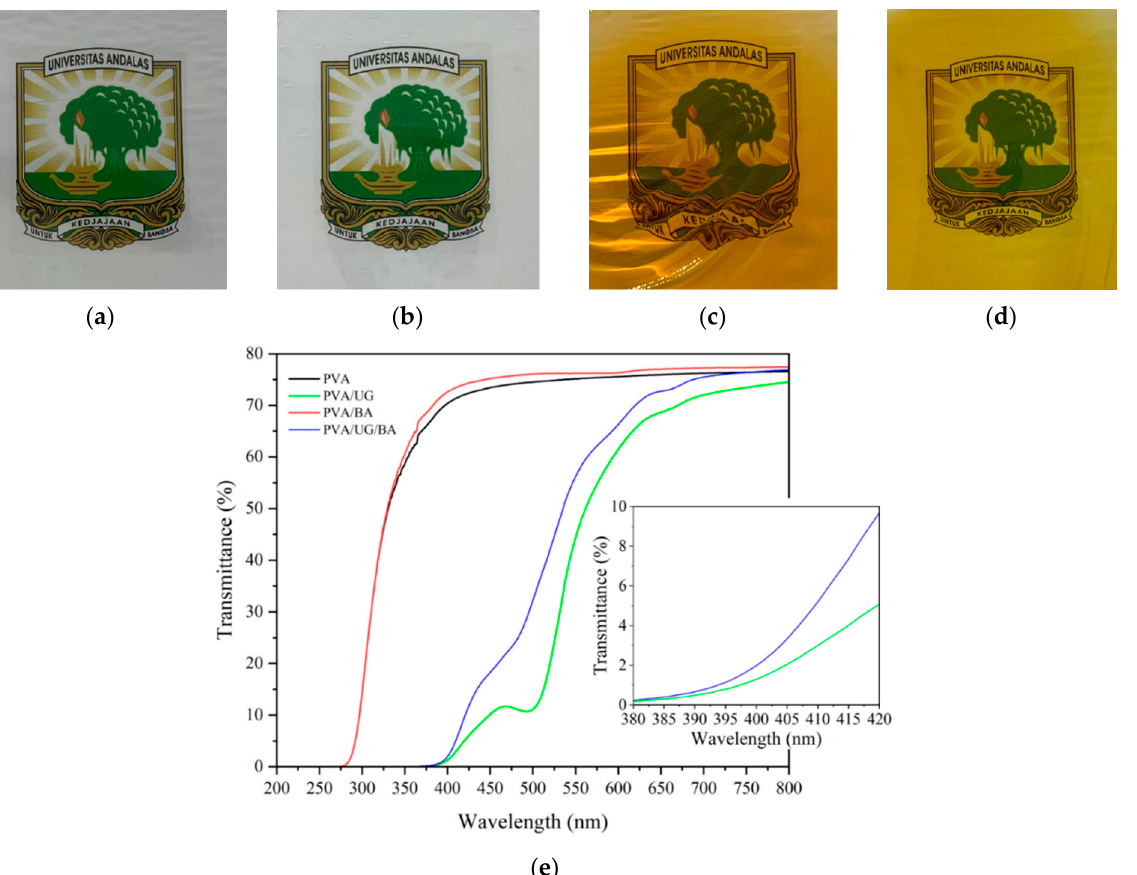
Figure 1. Photographs of the film for pure PVA ( a ); PVA/BA ( b ); PVA/UG ( c ); PVA/UG/BA ( d ). The light transmittance curves ( e ).